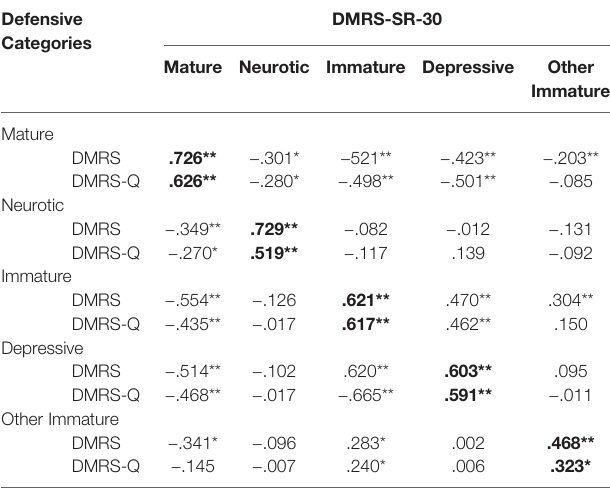
other immature defenses that had weak correlation with the the immature category, the correlations between the DMRS-SR-30 and the other measures were of greater magnitude for the